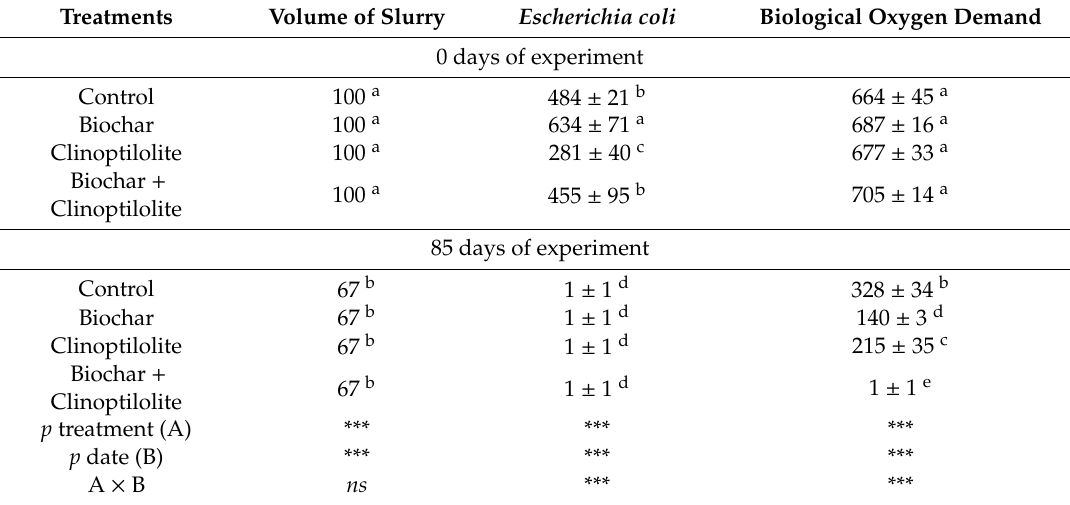
Table 2. Biological characteristics of the treatments at the beginning and end of the experiment (mean ± standard deviation) ( n =